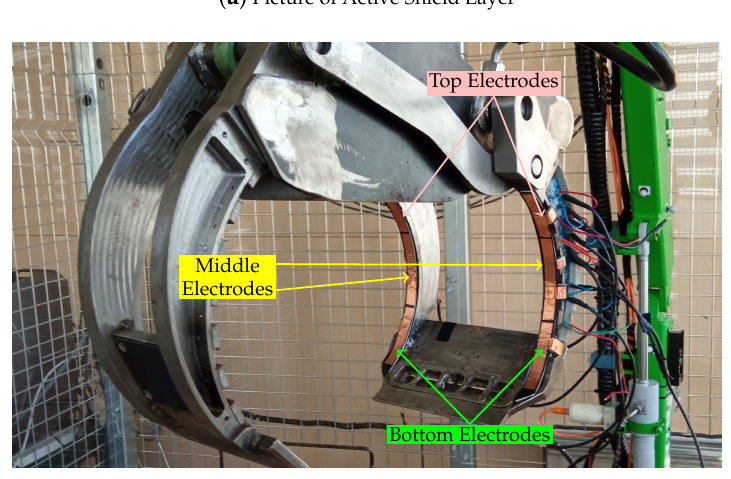
Figure 6. Experimental setup. ( a ) The placement of active shield layer on the gripper’s claw is shown. One of the cavities for holding the STIM is shown clearly on the gripper’s inner claw. The STIM is placed in a cavity on the right finger of the outer gripper. ( b ) The construction of the sensor